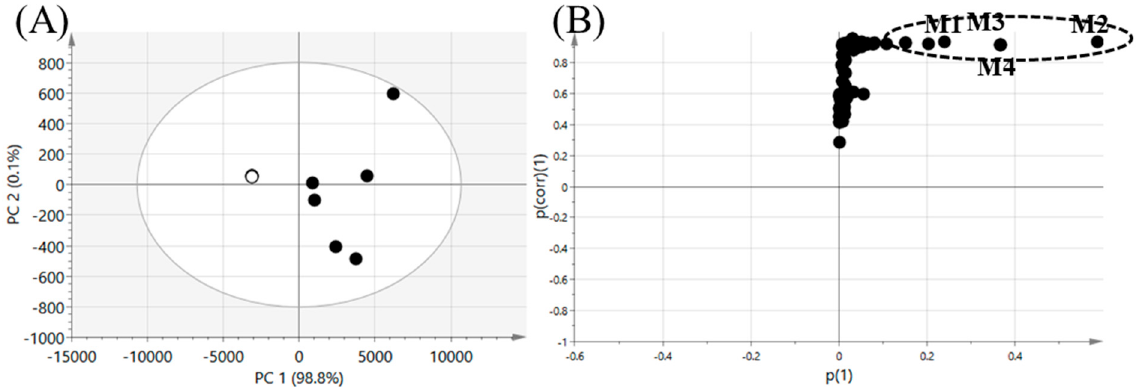
Figure 2. Multivariate analysis of seongsanamide A metabolites in human liver microsomes (HLMs). ( A ) Scores scatter plot generated by a principal component analysis (PCA) from the heat-deactivated HLMs ( S-plot generated by an orthogonal partial least-squares-discriminant analysis (OPLS-DA) model. Identified metabolites (M1–M4) are marked with abbreviations on the S-plot, and metabolite lists are provided in Table